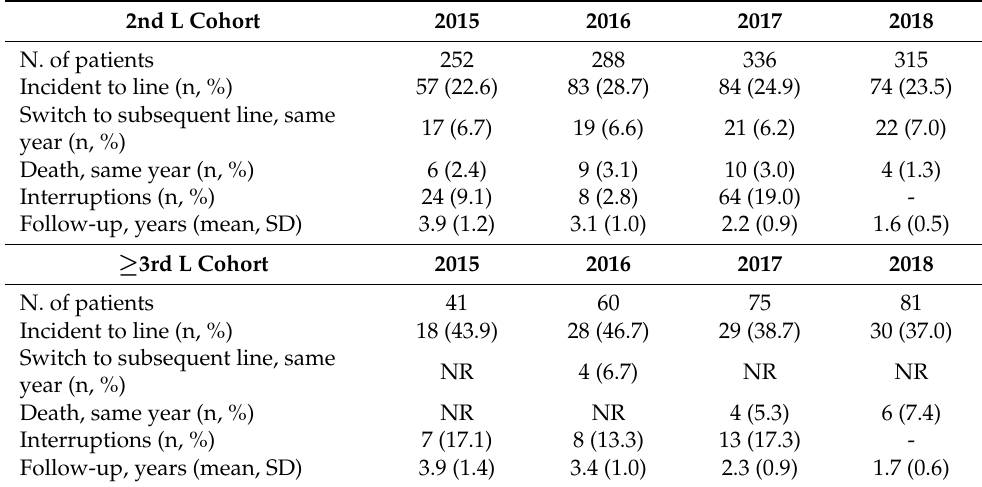
Table 2. Treatment patterns per calendar year of identification period (2015–2018).